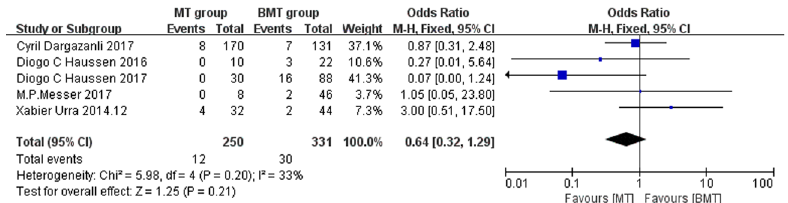
Fig 4. Forest plots of mortality. Forest plots showing the odds ratios of mortality in the patients treated with MT vs. those treated with BMT.